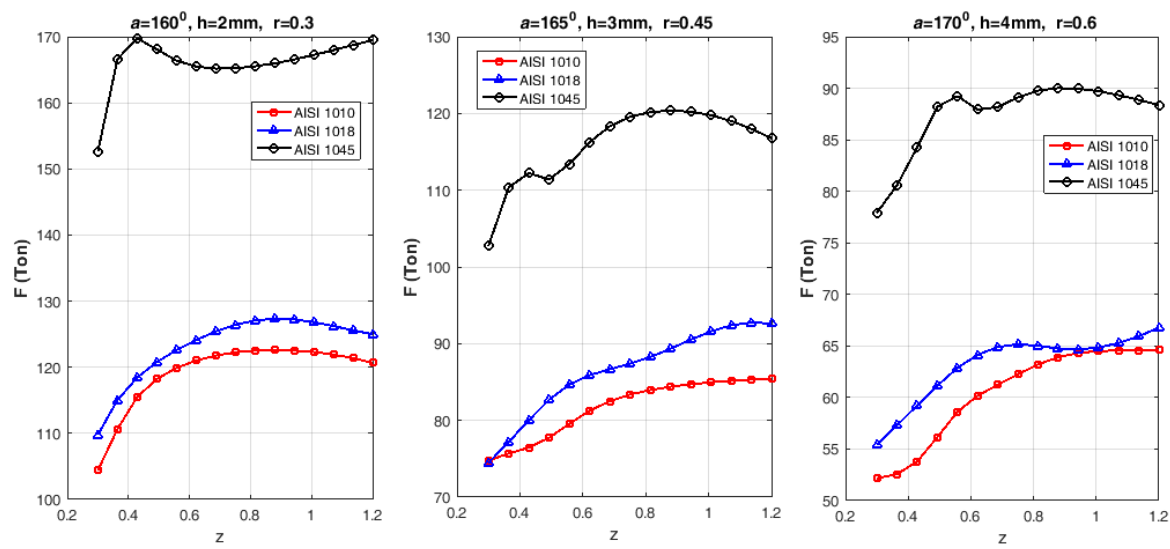
Figure 11. Comparison of forming response: punch force.